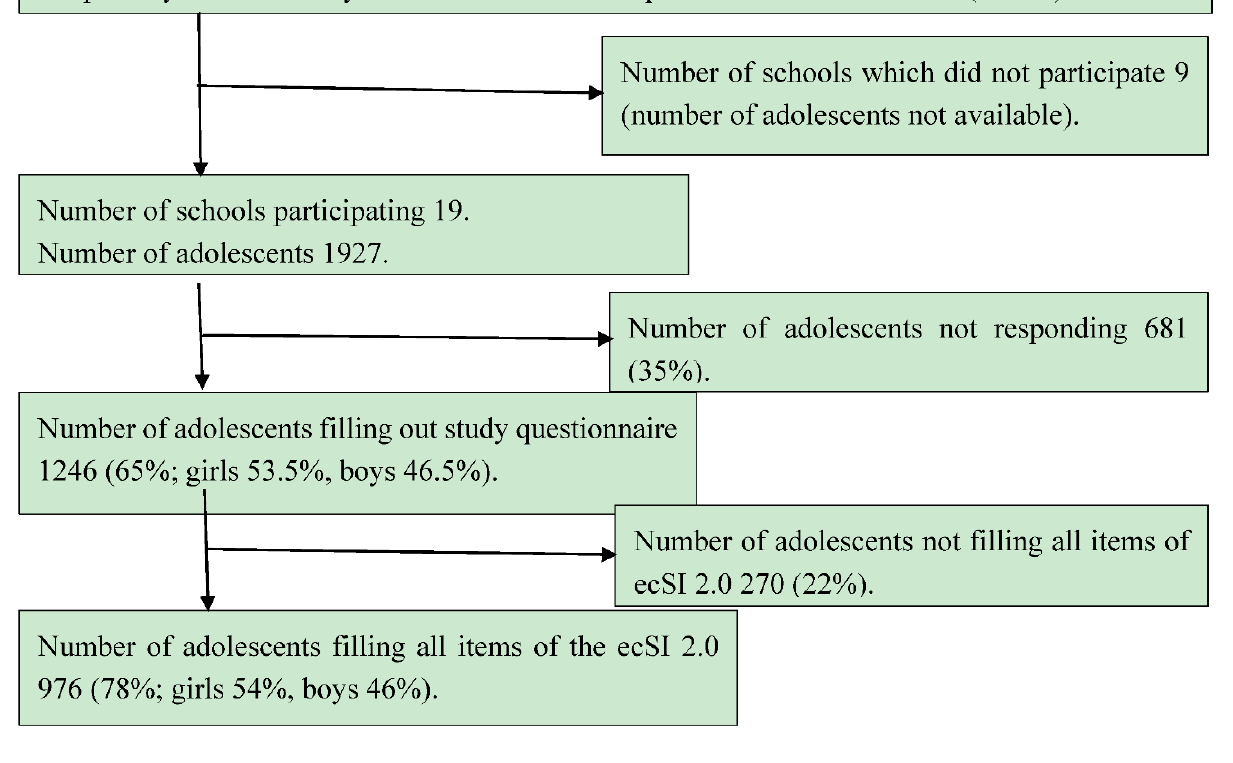
Figure 1. The study